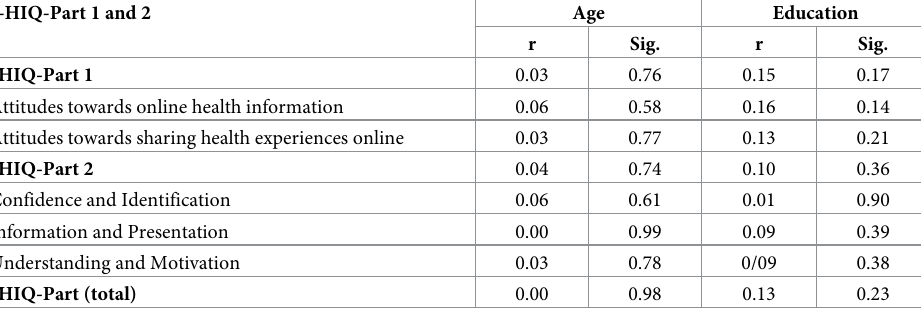
Table 3. Correlations of e-HIQ and its subscales with age and education.